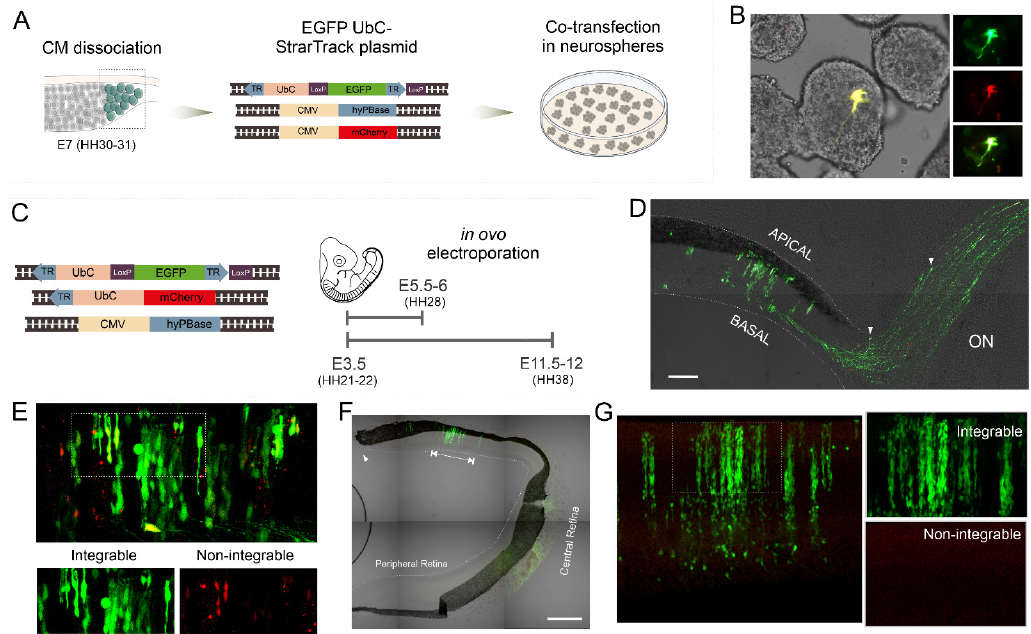
Figure 1. Expression of the UbC-StarTrack in vitro and in ovo. ( A ) General overview of neurospheres generation and co-transfection with an UbC-StarTrack integrable EGFP plasmid and a non-integrable vector expressing mCherry. ( B ) Epifluorescence and phase contrast merge image of co-transfected neurospheres. Positively labeled cells for both plasmids were evident in retinal neurospheres. Green (EGFP), red (mCherry) and yellow (merge). ( C ) Diagram showing procedure followed for the in ovo electroporation of an integrable UbC-StarTrack vector (expressing EGFP) along a non-integrable UbC-StarTrack vector (expressing mCherry). Labeled cells were checked either two or eight days after the IOE of the three constructs. ( D ) Epifluorescence and phase contrast merge image of a horizontal section passing throughout the ventral part of the central retina at E5.5-6 (HH28). Note the EGFP-labeled axons (arrows) heading toward the formation of the optic nerve (ON). Co-electroporation was performed in the peripheral retina and labeled cells are located next to the central retina. Scale bar 100 µ m. ( E ) Labeled green (integrated), red (episomal) and yellow (both) cells are shown in short-term E5.5-6 (HH28). Inset is shown below both in green and red channels at higher magnification. ( F ) Epifluorescence and phase contrast merge image of a retinal section at E11.5-12 (HH38). The peripheral retina, which extends from the proximity of the CM (arrowhead) towards the central retina, is shown. Cell clusters are located in columns along the radial axis of the retina occupying a limited area in the peripheral retina (arrows). Nasal retina is upwards and temporal retina is downwards. Co-electroporation was performed in CM. Scale bar 500 µ m. ( G ) In the long-term, E11.5-12 (HH38), just the integrated UbC-EGFP labeling persists. Merging green and red channels are successively